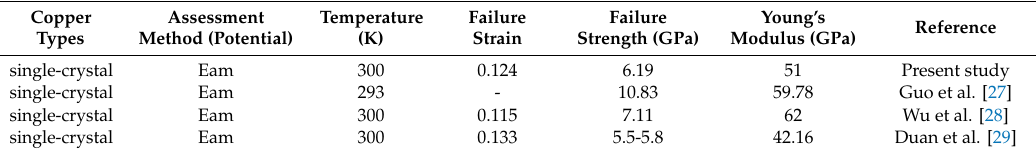
Table 2. The results of previous work compared with the three mechanical values of the single crystal copper in this study.